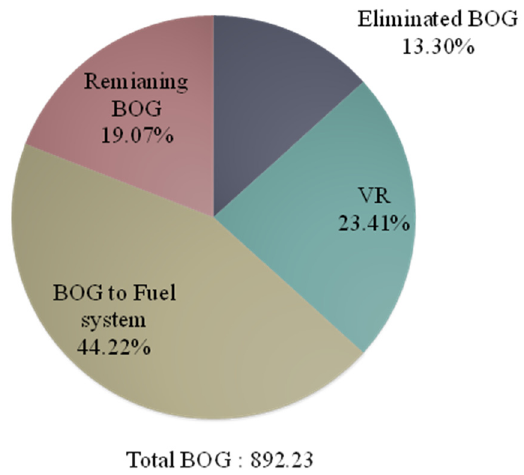
Figure 8. BOG distribution in LNG subcooling in MCHE strategy.